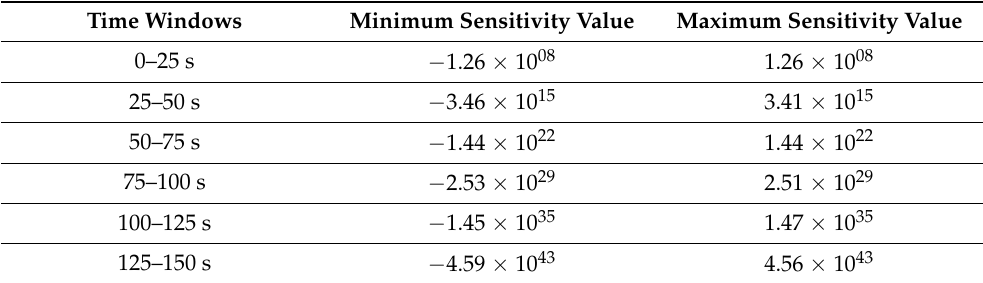
Figure 8. Time-evolution of T ( t ) (blue graph) with uncertainty bands T ( t ) ± σ (yellow graphs), considering uniform 5% relative standard deviations for all parameters and 5% absolute standard deviations for the initial conditions in Region 3 for m = 2.80. Table 8. Maxima and minima of the uncertainty of T ( t ) considering a 5% std. dev. for all parameters and initial conditions in Region 5 for various time